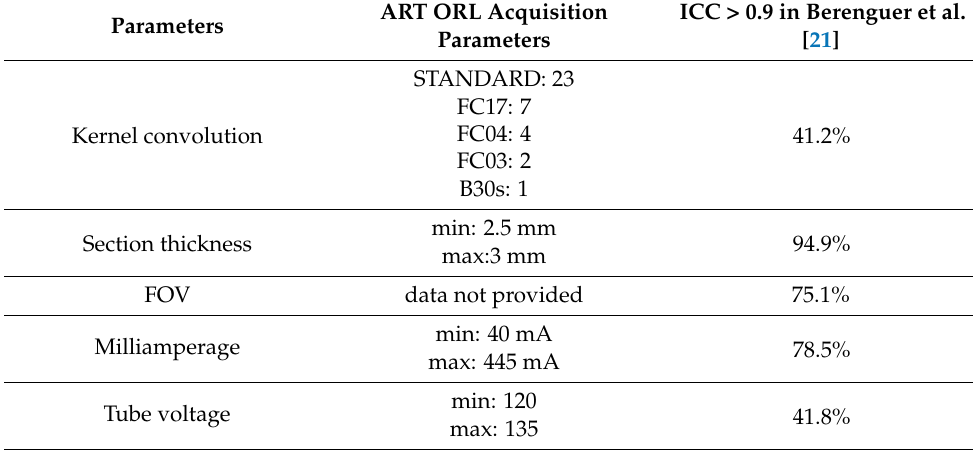
Table A4. Acquisition parameters of ART